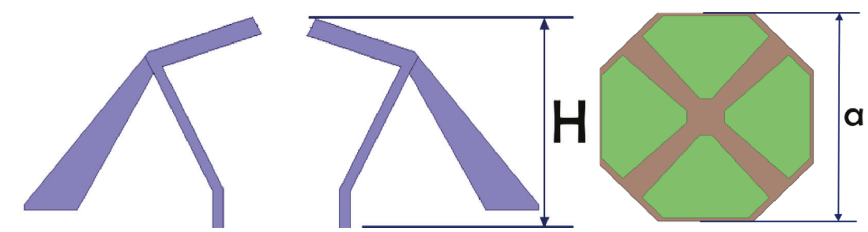
Figure 5: Structure of the improved dipole and the patch.